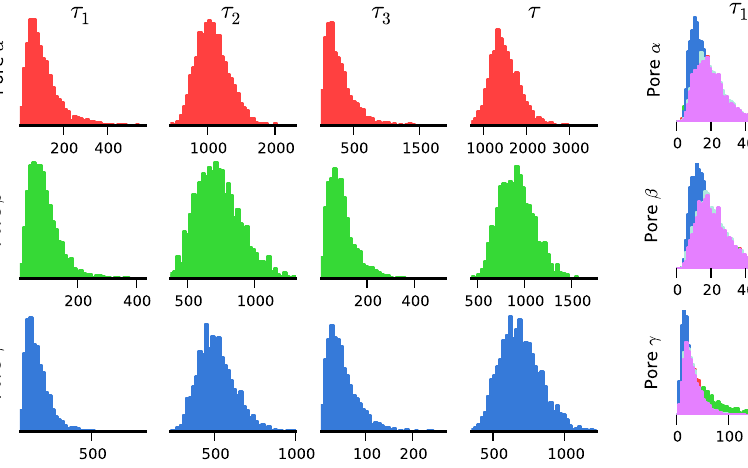
FIG. 7. Comparison of the filling, transfer, escape, and translocation time distributions for the three pores at F ¼ 0 : 5 and (cid:1) ¼ 1 : 5 .